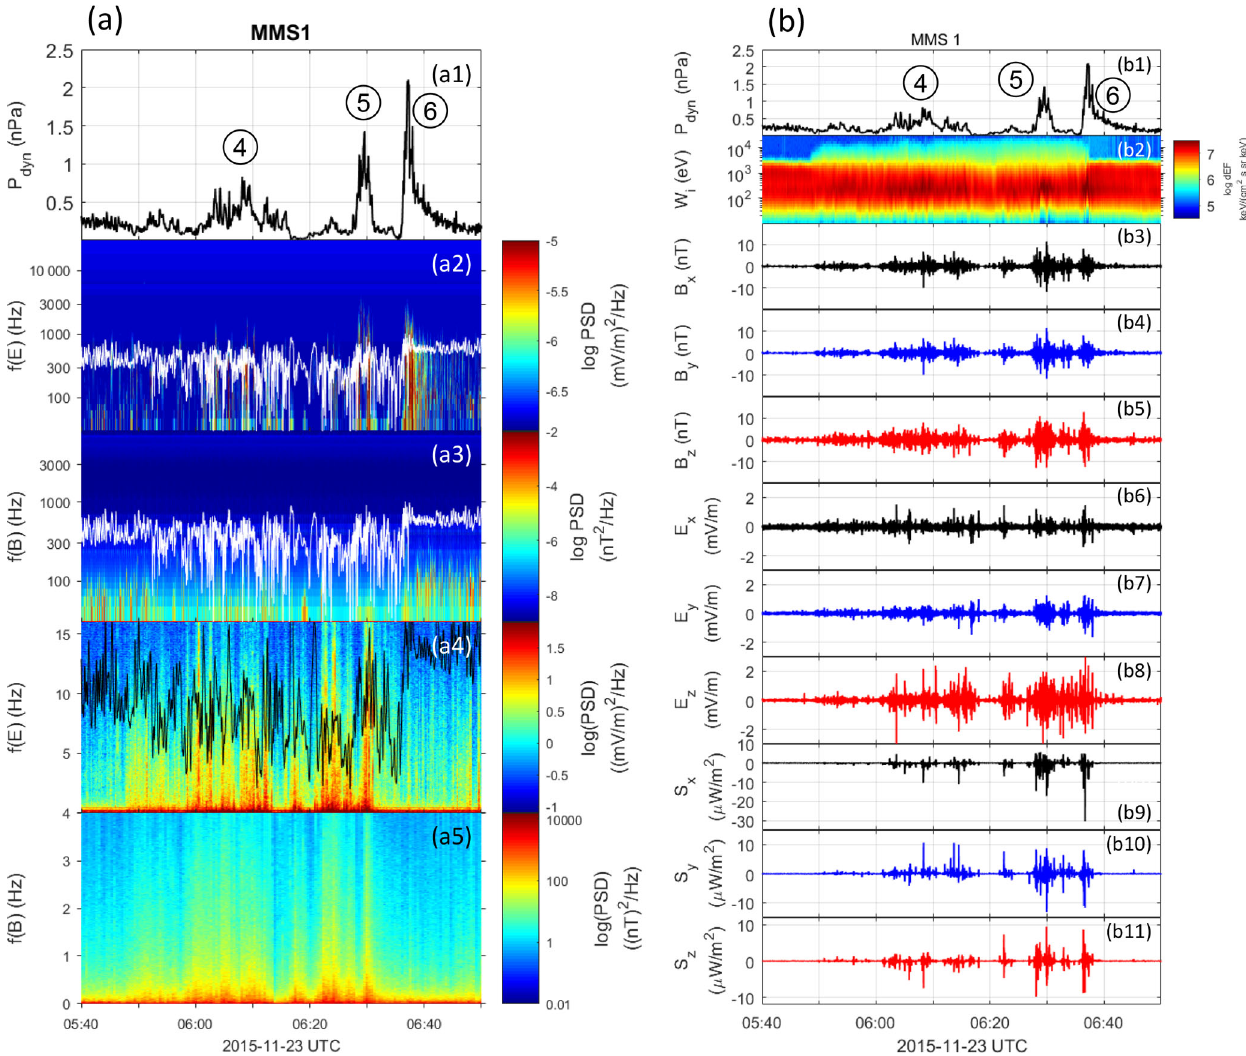
Figure 12. (a) High- and medium-frequency wave activity on 23 November 2015 in the same format as Fig. 6. (b) Low-frequency wave activity for the same time interval as in (a) , and in the same format as Fig.